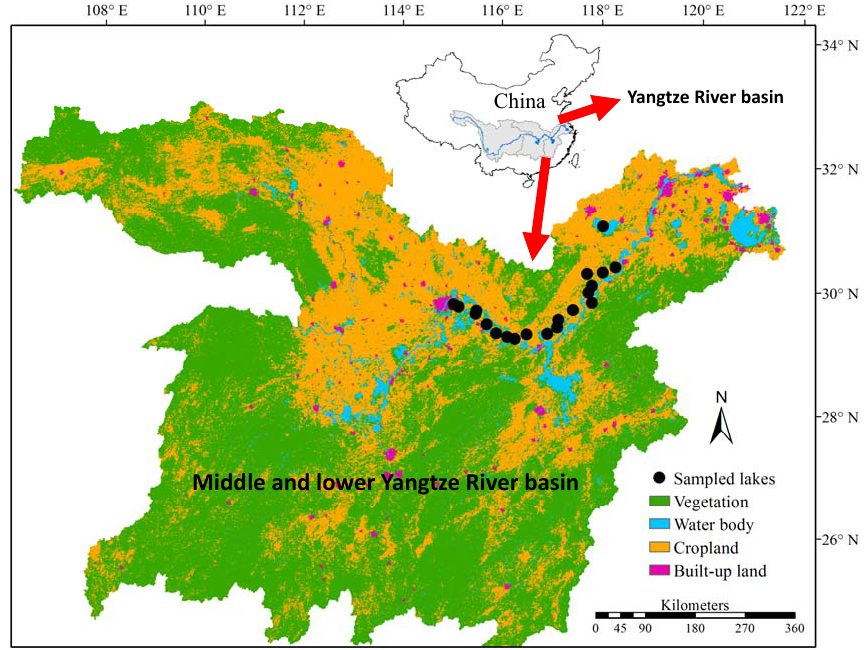
Figure 1. Locations of the Yangtze River basin and 20 studied lakes in